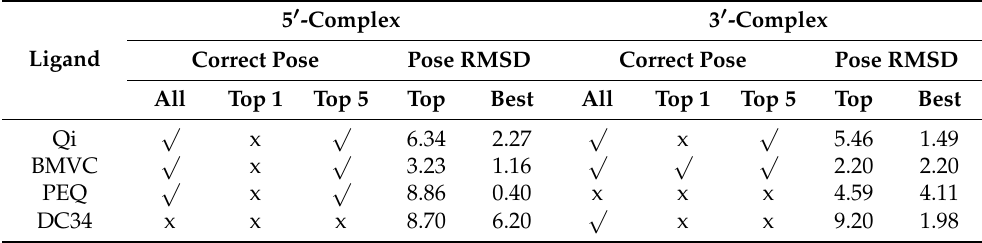
Table 3. Results obtained using Glide